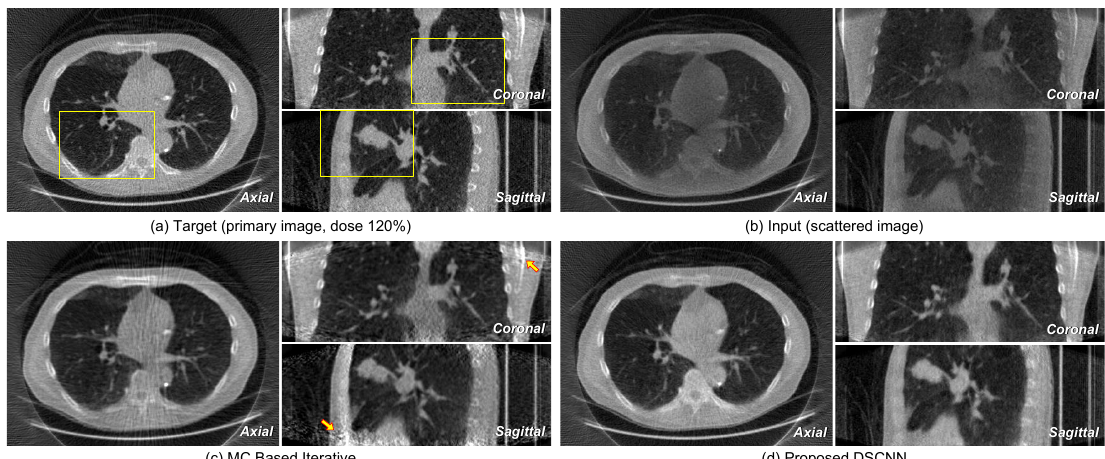
Figure 12. Comparison of 3D reconstructed images: target primary image ( a ); input scattered image ( b ); and after scatter correction ( c , d